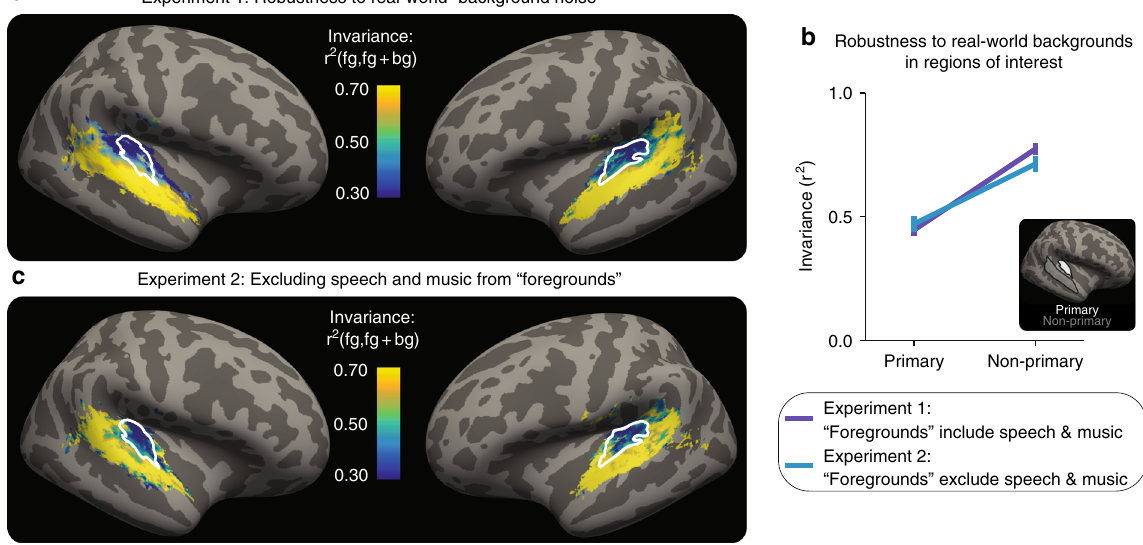
Fig. 2 Non-primary auditory cortex is robust to real-world background noise. a The results of Experiment 1 ( n = 11): map of invariance metric, averaged across participants. White outlines: primary-like areas, de fi ned anatomically. b Median of invariance metric in a primary and non-primary region of interest (ROI), averaged across participants and hemispheres. Inset shows ROIs on the in fl ated brain. Error bars are within-participants SEM. Inset: outlines of anatomical ROIs. c The results of Experiment 2 ( n = 12). Experiment 2 was similar to Experiment 1, but without speech or music stimuli. Plotting conventions, including colorscale, are identical to ( a